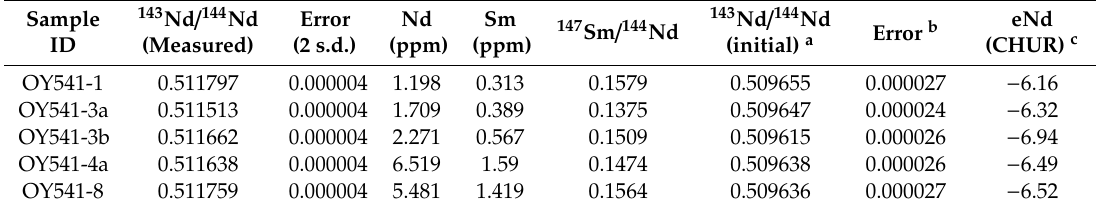
Table 4. Sm-Nd isotope data of Platreef